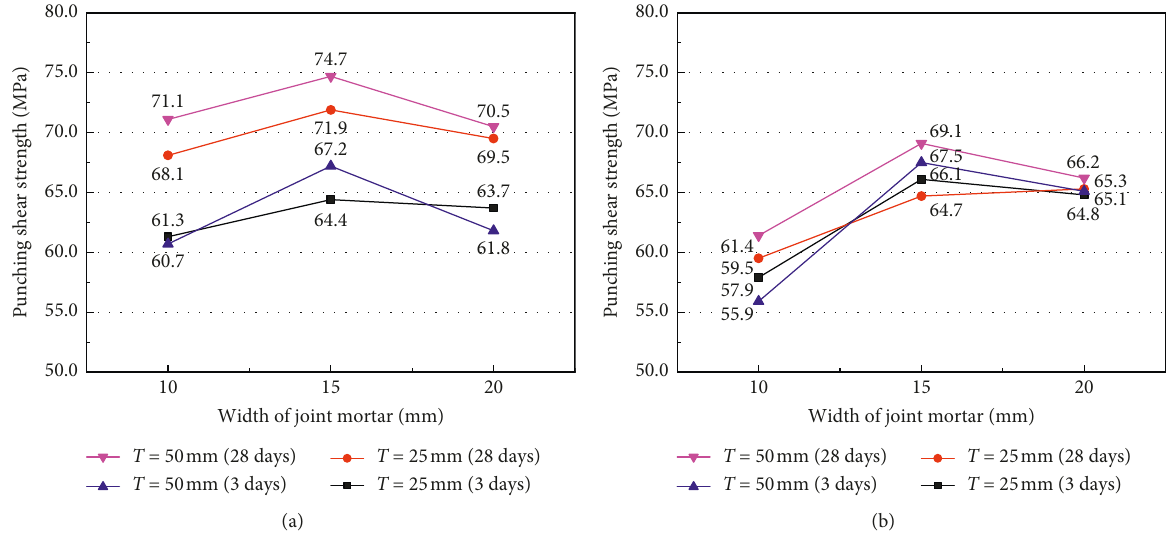
Figure 9: Test outcome of punching shear. (a) Fully restrained. (b) Semirestrained.